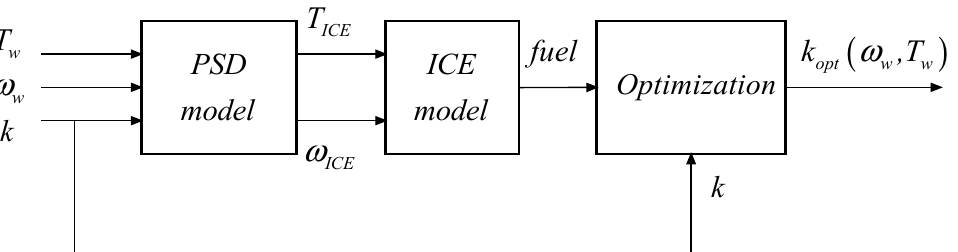
Figure 5. ICE efficiency contour map.